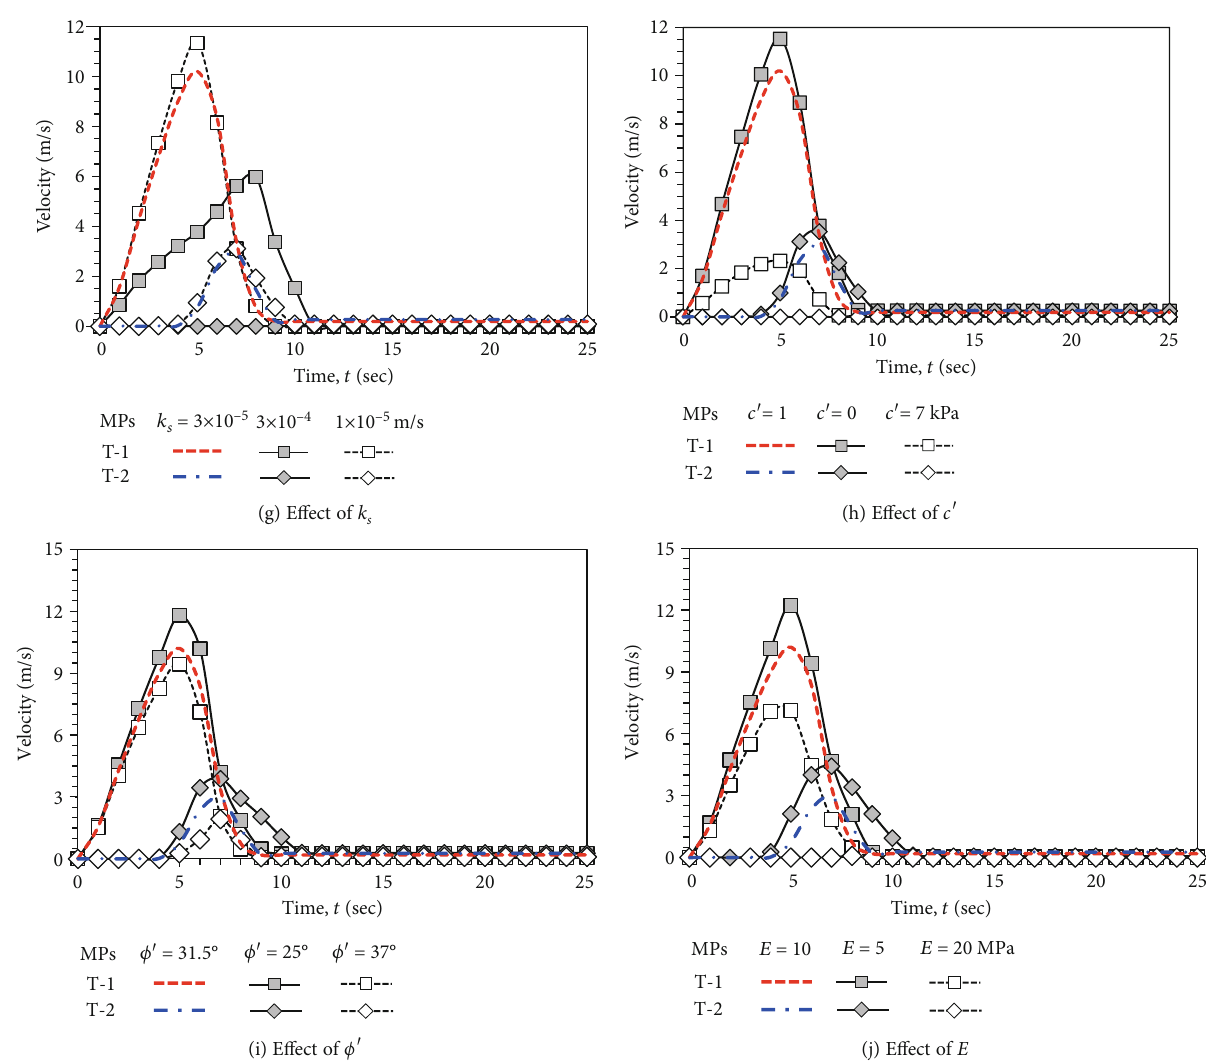
Figure 10: In fl uence of di ff erent input parameters on the variation of slope displacement and velocity with time: (a – e) displacement and (f – j)